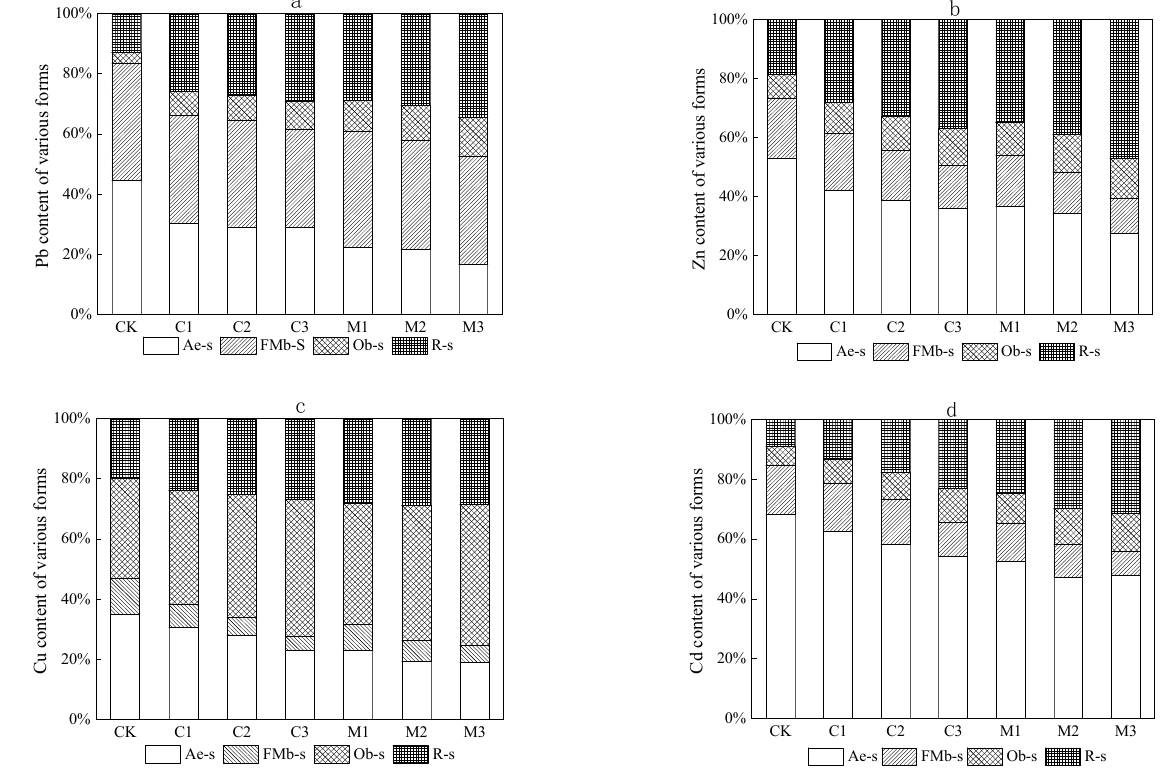
Figure 4. Heavy metal form content in tailings under improved treatment: ( a ) Pb, ( b ) Zn, ( c ) Cu, ( d )